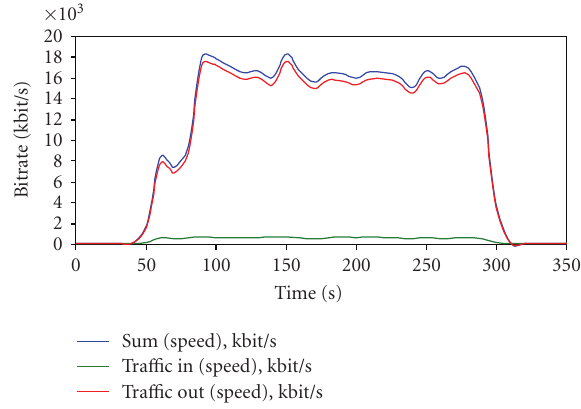
Figure 9: Bitrate versus Time for G@L